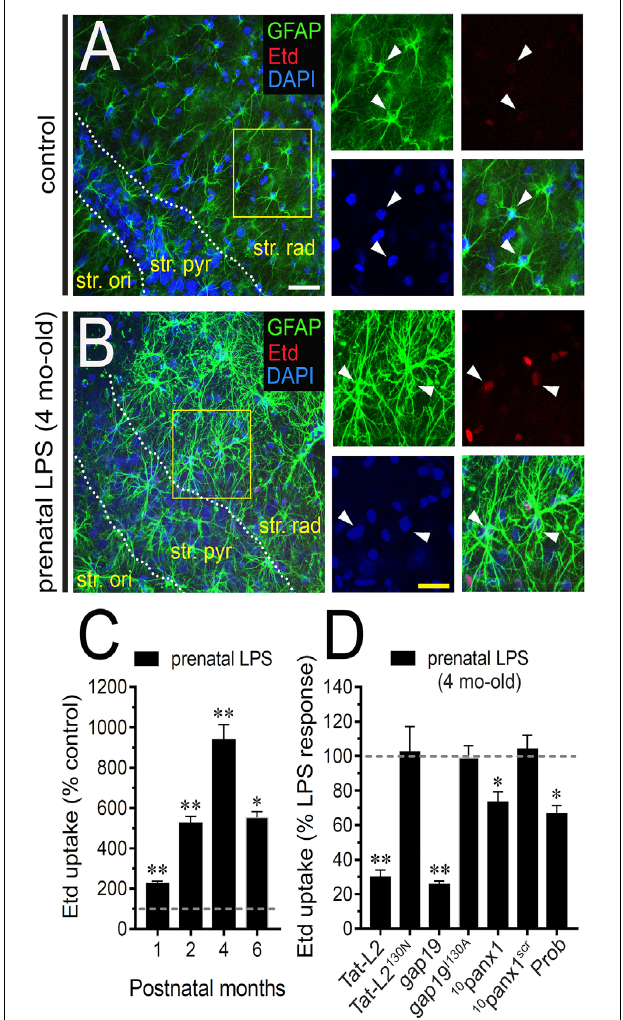
FIGURE 1 | Prenatal LPS exposure augments the activity of Cx43 hemichannels and Panx1 channels by astrocytes on offspring hippocampus. Representative images showing GFAP (green), Etd (red) and DAPI (blue) staining in the hippocampus of control offspring (A) or prenatally LPS-exposed offspring (B) of 4 months old. Insets of astrocytes were taken from the area depicted within the yellow squares in (A,B) . (C) Averaged data of Etd uptake normalized to control conditions (dashed line) by hippocampal astrocytes in acute slices from prenatally LPS-exposed offspring after following different postnatal periods. ∗∗ p < 0.0001, ∗ p < 0.001 versus control, one-way ANOVA Tukey’s post hoc test, mean ± S.E.M., n = 3. (D) Averaged data normalized to the maximal effect (dashed line) induced by prenatal LPS exposure on Etd uptake by hippocampal astrocytes in acute slices from 4 months old offspring exposed to the following